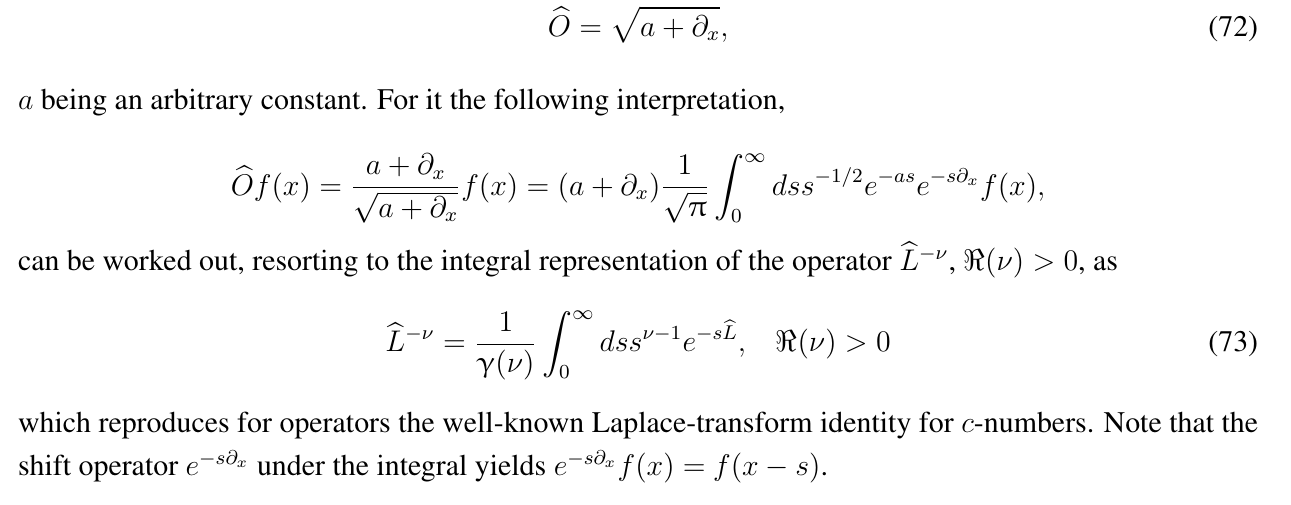
Figure 4. ( a ) τ -evolution of the Euclidean norm | ψ | 2 = ψ 2 ψ of the (1+1)D Salpeter equation for the input given by Equation (66) (see Figure 3), shown at τ = 0 (red solid line), τ = 0 . 3 (blue dotted line), τ = 0 . 6 (green dashed line), and τ = 1 (magenta dash-dotted line). ( b ) τ -evolution of the squared amplitude of the solution of the Salpeter equation obtained through Equation (71) for the Gaussian initial wave function 2 ψ ( ξ ) = e − ξ 4 , shown at τ = 0 (red solid line), τ = 1 (blue dotted line), τ = 1 . 5 (green 0 dashed line), and τ = 2 (magenta dash-dotted